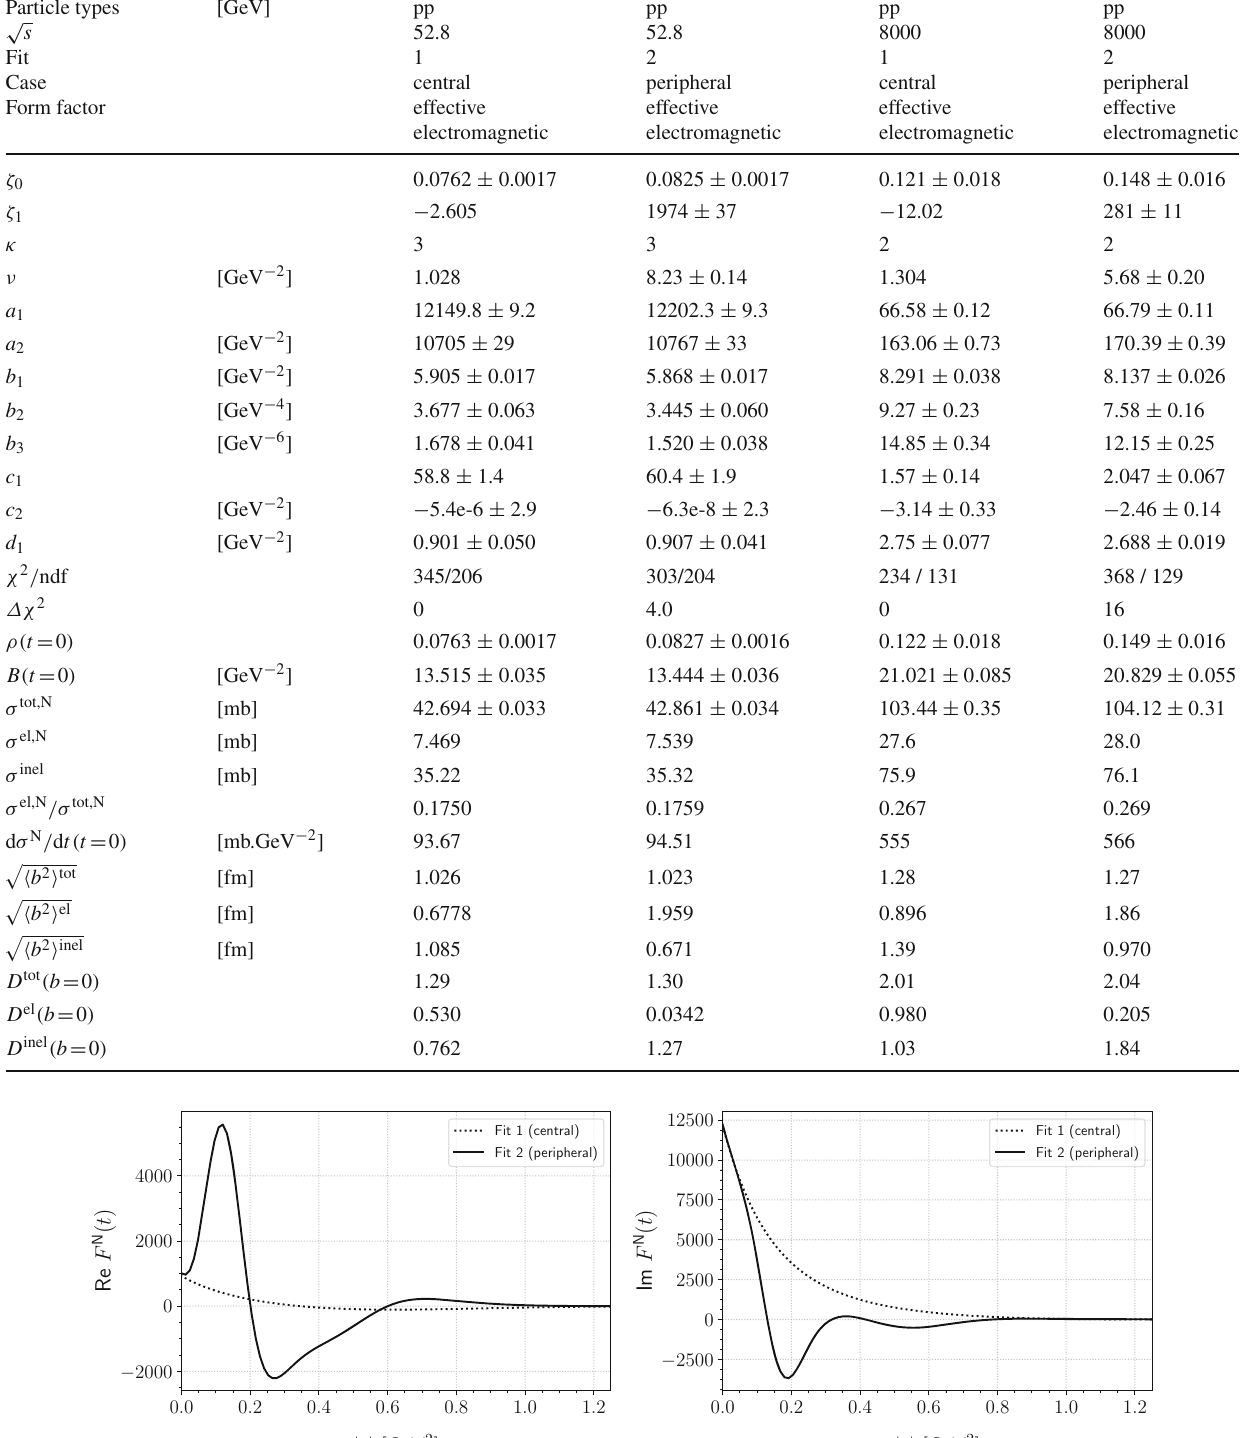
Table 1 Comparison of several hadronic quantities characterizing pp elastic scattering at energy of 52.8 GeV and 8 TeV. Values of free parameters specifying elastic hadronic amplitude F N ( s , t ) have been